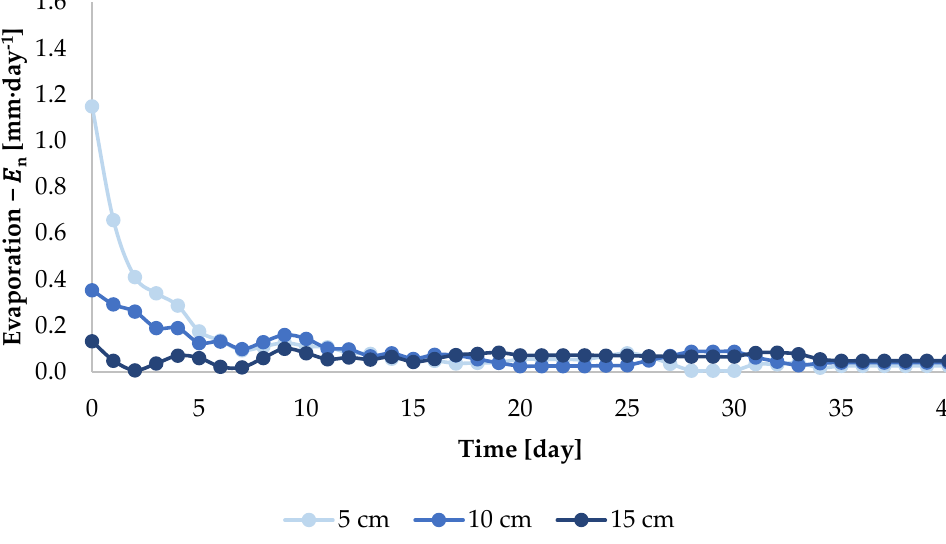
injection depths of 5, 10 and 15 cm, on the example of the dose of 450 cm 3 , are presented